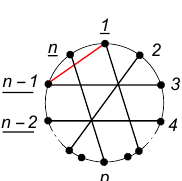
Figure 2 . Graph representation of A ( I n : 1 p − 2 , 2 p +2 , 3 n − 1 , . . . , np ) in the double cover language.